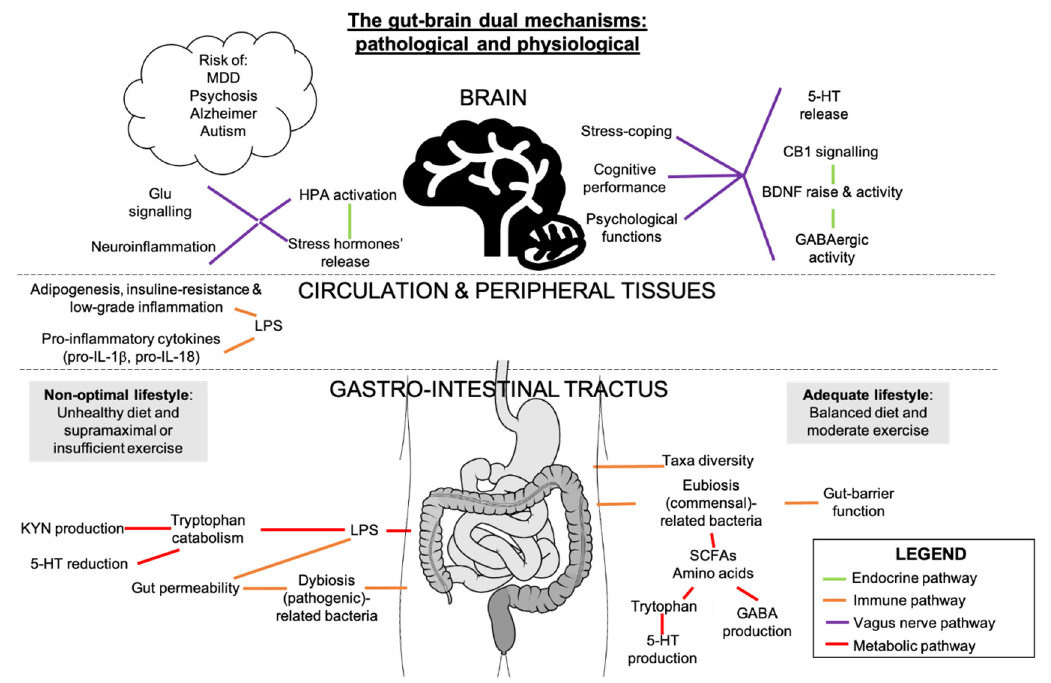
Figure 3. Gut-brain axis routes in mental health. The gut microbiota and the CNS are connected through immune, vagus nerve, metabolic and neuroendocrine-mediated pathways. These processes can all contribute to mental health or illness where eCBs and other molecules interfere depending on the cell or tissue. SCFAs are primary products of the fermentation of complex fibers by gut microbes in an intestinal balanced environment i.e., eubiosis. SCFAs induce GABA and serotonin (5- HT) production, attenuating depressive-like behavior. These neurotransmitters can also exert their roles in the brain where, with BDNF and CB1, they can bring positive mood changes. On the other hand, LPS-mediated low-grade inflammation in the gut caused by disruption of microbiota composition (dysbiosis) and intestinal barrier perturbation, would induce tryptophan degradation, raising kynurenine (KYN) levels and reducing 5-HT release, two events associated with depressive mood. The action of pro-inflammatory interleukins (pro-IL) and LPS would evolve in an inflammatory state in the brain. Inflammatory stimuli and stressor exposure would engage HPA overstimulation. HPA function through GC and ACTH circuitry release in gut microbiota-mediated anxiety-like behaviors is notable (Kang et al., 2014). Strong bidirectional correlations are found between major depressive disorder (MDD), psychosis, Alzheimer’s disease, autism spectrum disorder and intestinal dysbiosis, which correlates with the dietary and exercise